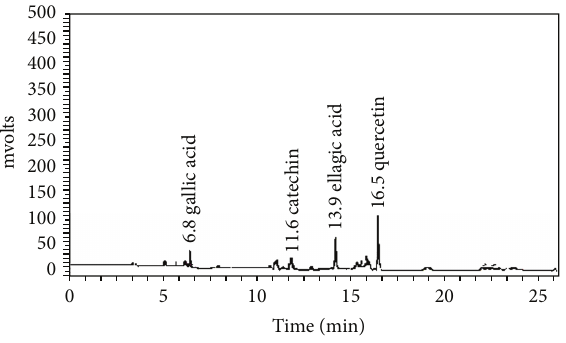
Figure 1: HPLC chromatogram of L. coromandelica